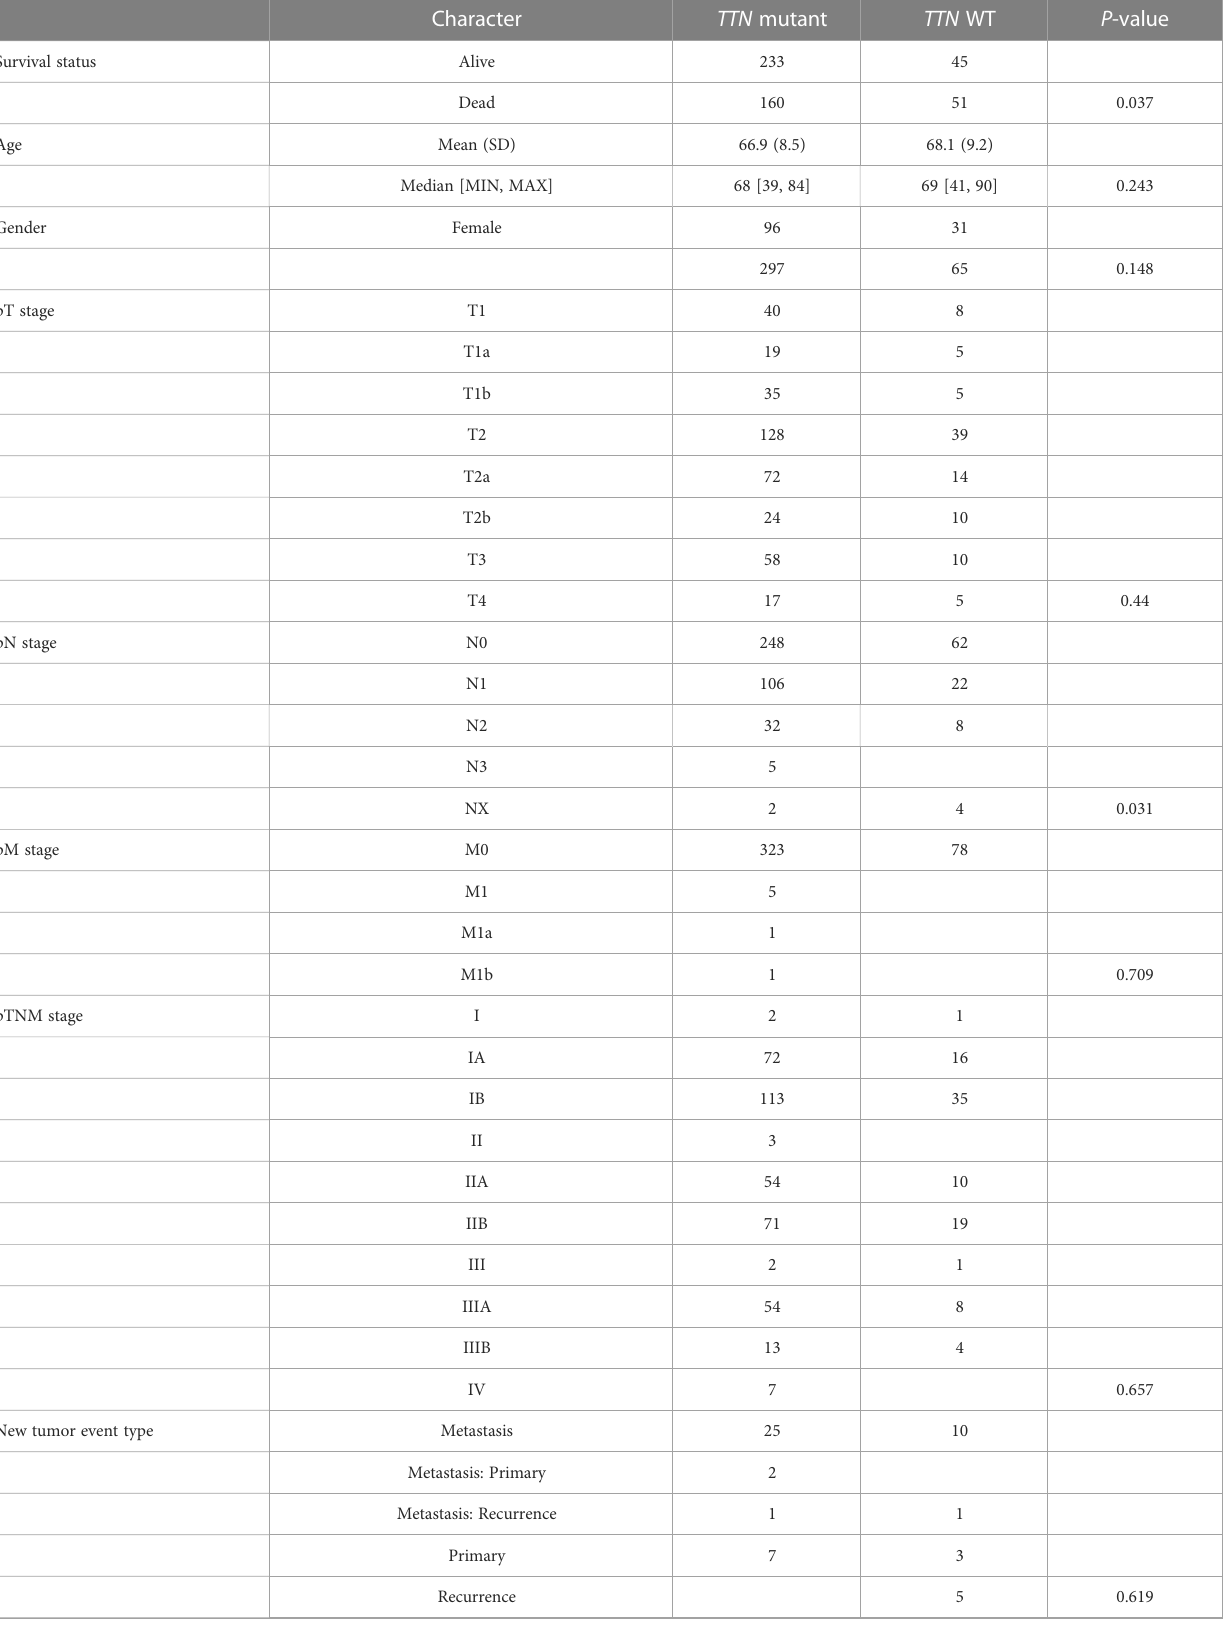
TABLE 1 Correlation analysis between TTN mutation and clinicopathological characteristics of